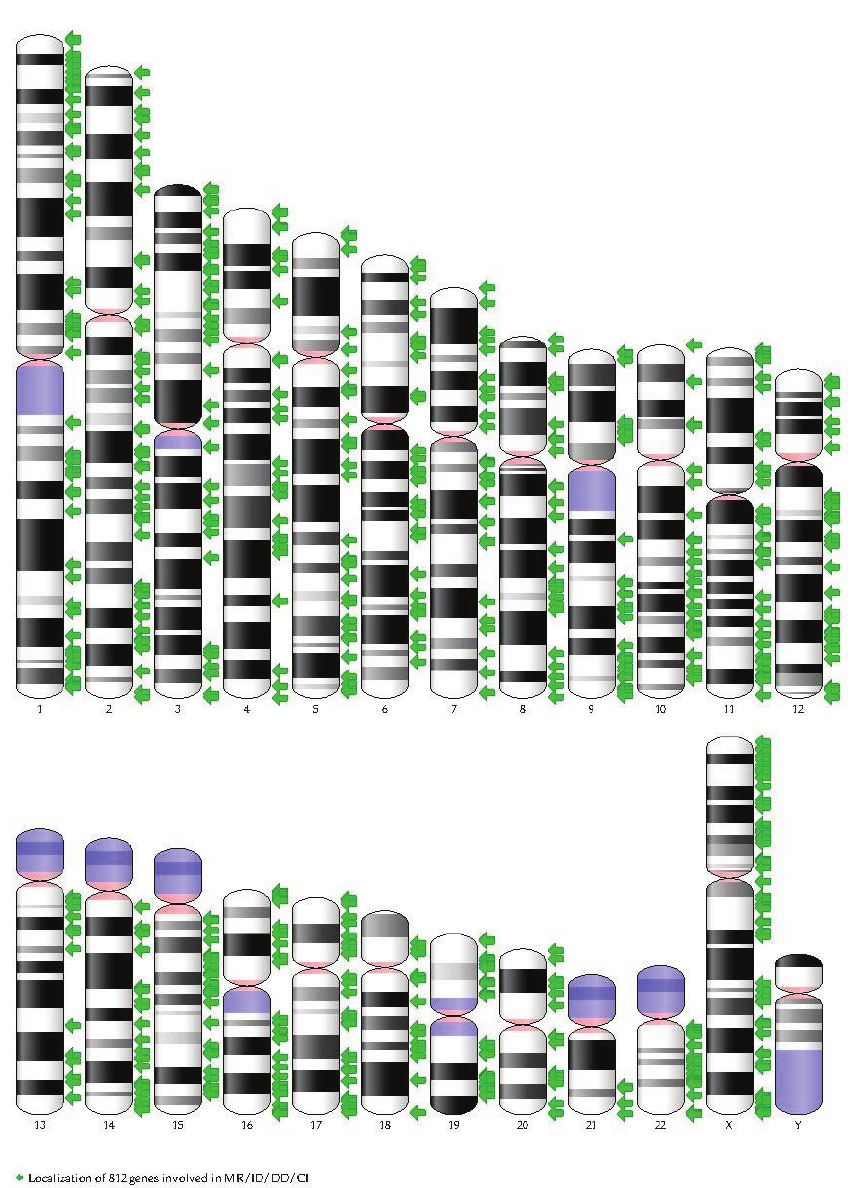
Figure 4. Mapping of the intellectual disability genes on the human karyogram (G-banded) using the Genome Decoration page at National Center for Biotechnology Information. See website at http://www.ncbi.nlm.nih.gov/genome/tools/gdp. Please note that genes causing ID tend to concentrate in G-negative bands, like all other genes. CI, cognitive impairment; DD, developmental delay; ID, intellectual disability; MR, mental retardation.